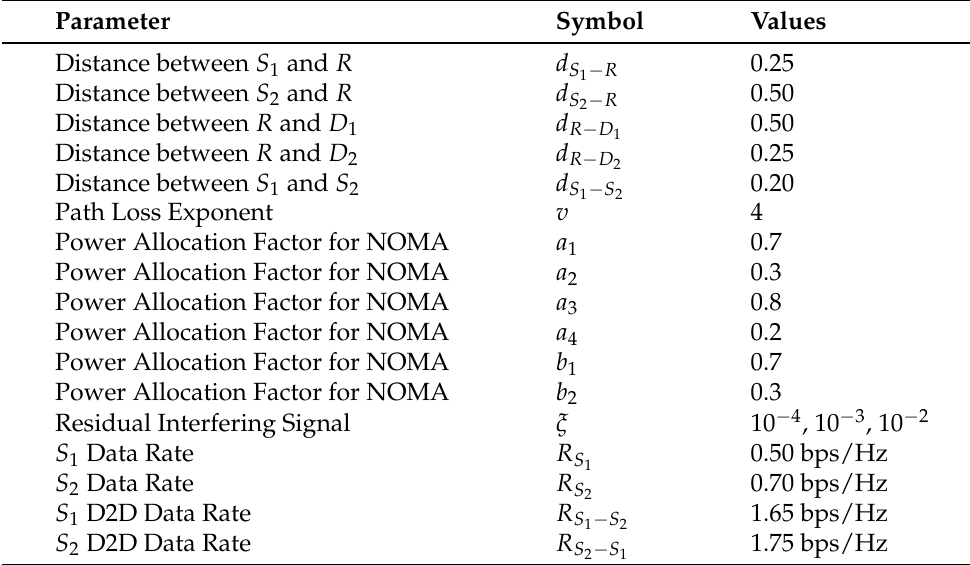
Table 1. Simulation